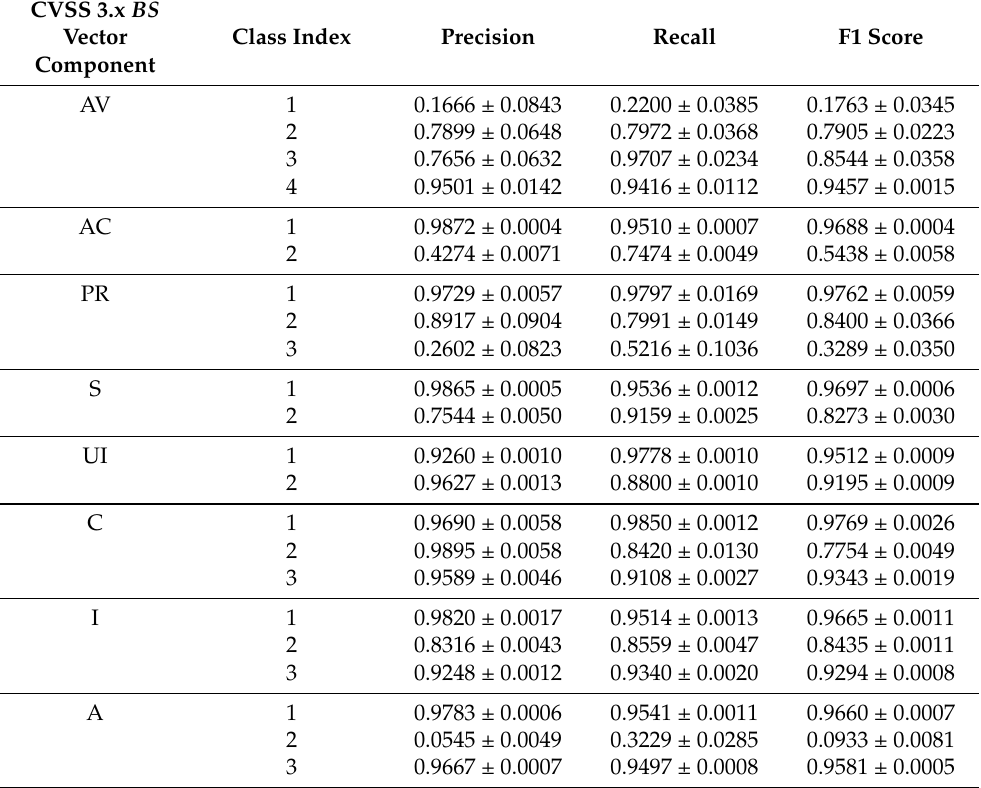
Table 6. Precision, recall, F1-score, and MCR calculated for the algorithms listed in Table 4 obtained from the 10 testing trials of the algorithms with a randomly selected 71,000-element testing